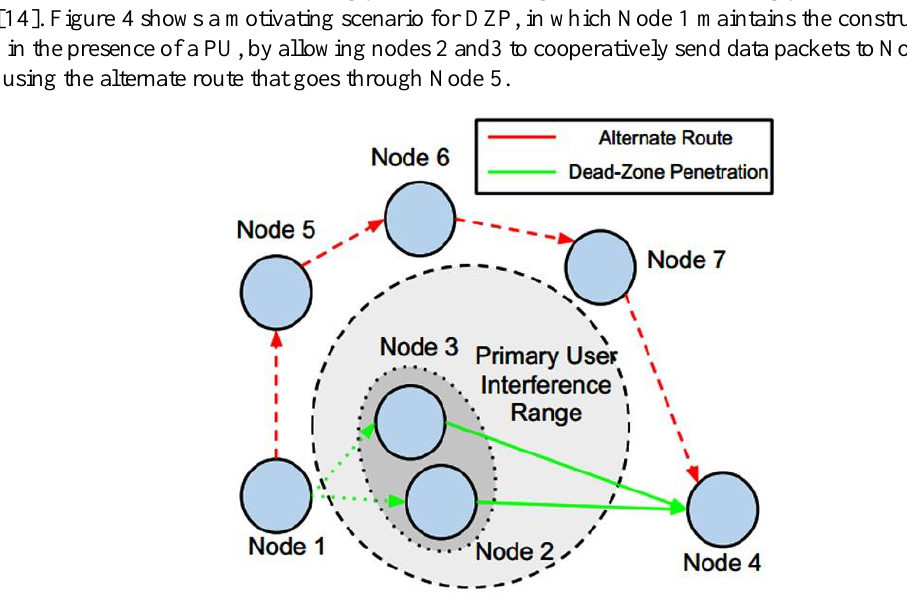
Figure 4. Dead Zone Penetration